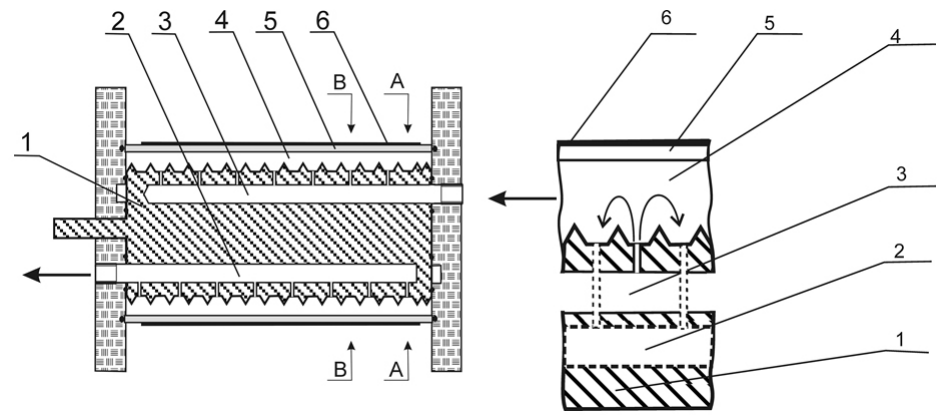
Figure 1 : Schema of the barrier reactor: 1 – high-voltage electrode, 2, 3 – internal channels, 4 – discharge zone, 5 – dielectric barrier, 6 – grounded electrode.